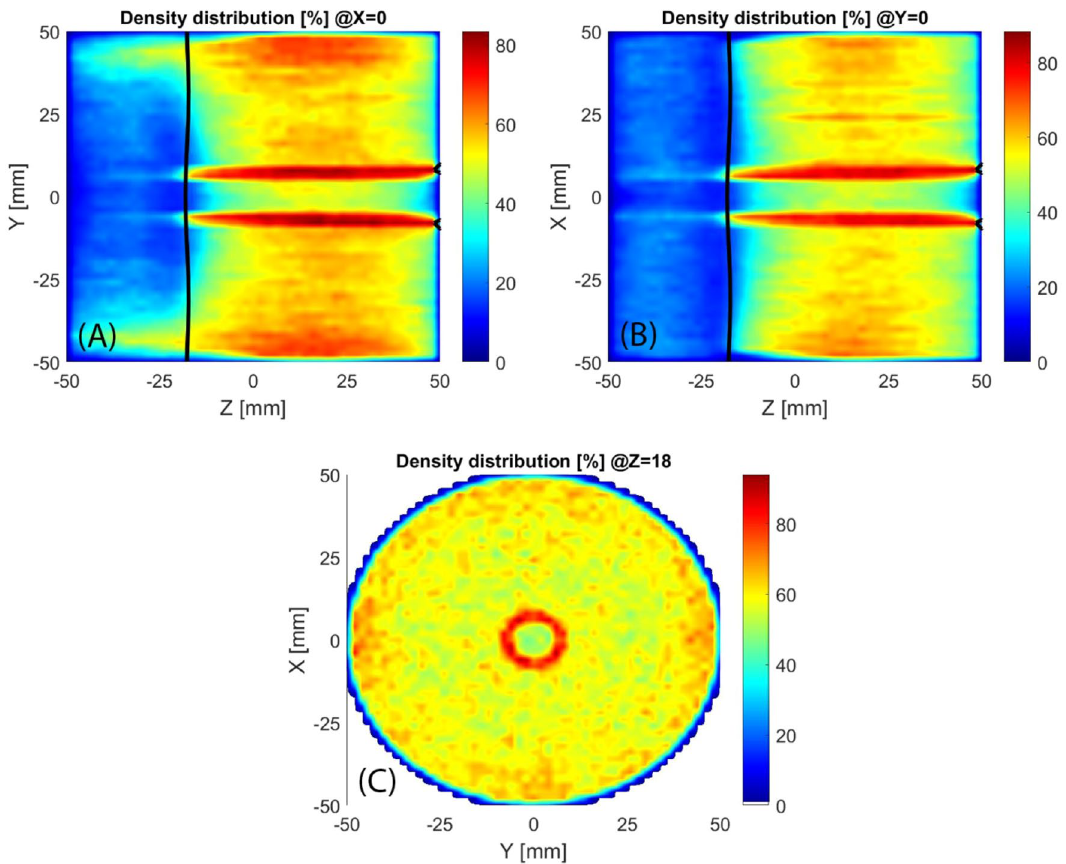
Figure 17. Longitudinal sections ( A , B ) and transversal section ( C ) of electron density, black lines mark the ECR